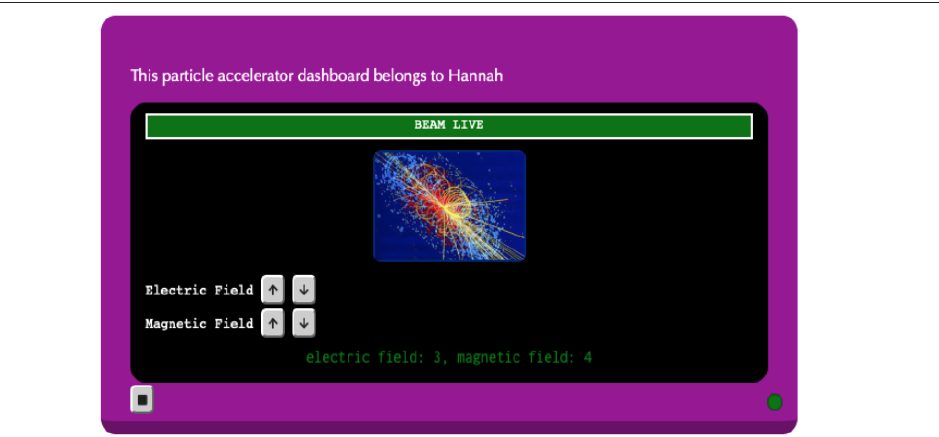
Figure 4. An example of a finished Website